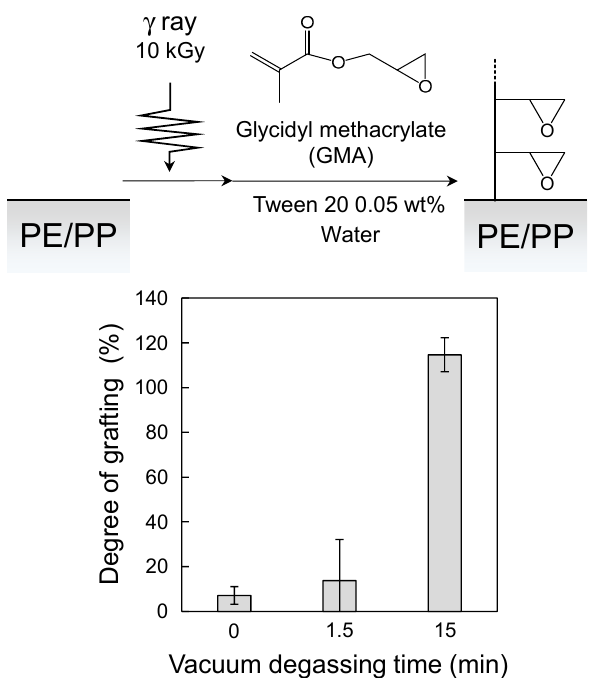
Figure 2. Relationship between degree of grafting and vacuum degassing time at 10 kGy. Error bars indicate standard deviation.